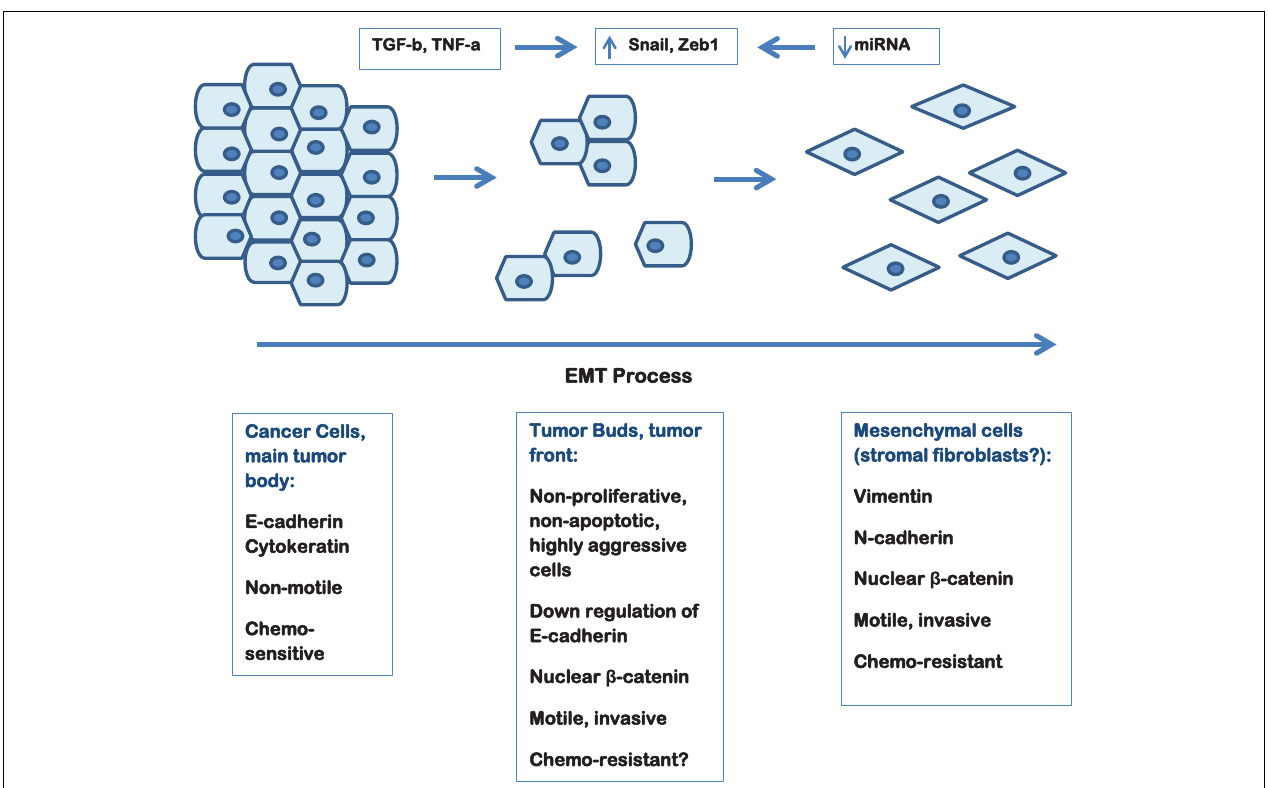
FIGURE 1 | Schematic representation of the EMT process in pancreatic cancer depicting the hypothetical link to tumor budding .